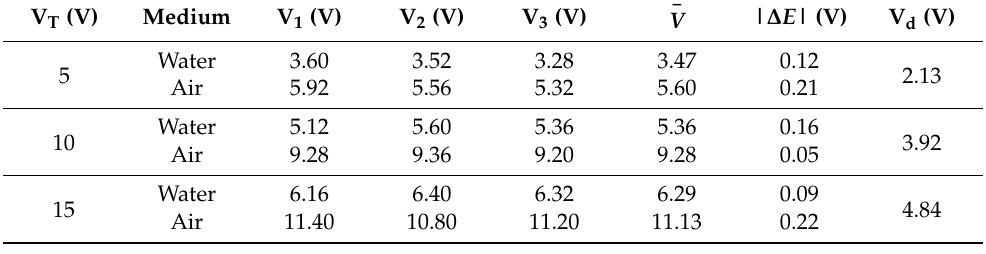
Table 5. Evaluations with different amplitudes.